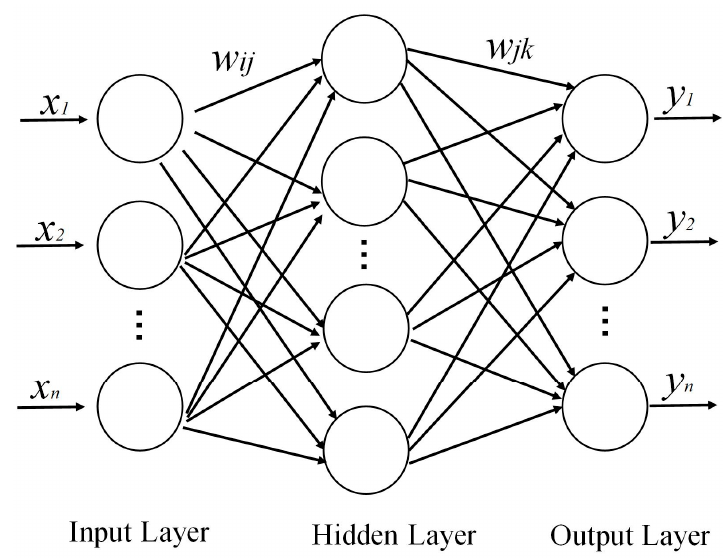
Figure 1. The structure of BP neural network.